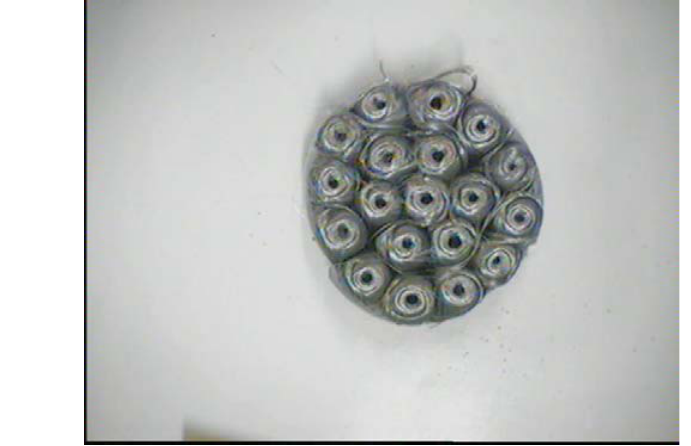
Figure 3 – Arrangement of spools in the bomblet, top view (Serbian Armed Forces, 1999) Рис . 3 – Расположение катушек в бомбе малого калибра , вид сверху (Serbian Armed Forces,